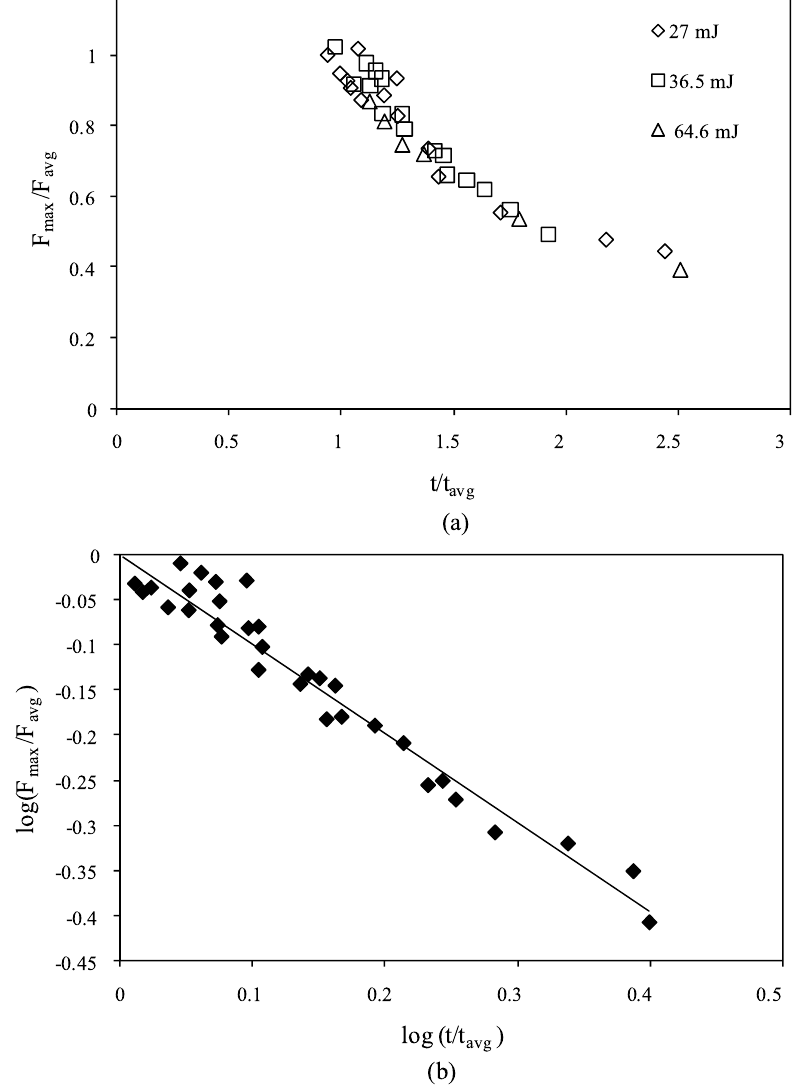
Fig. 5. Normalised load-time plots on (a) linear and (b) logarithmic